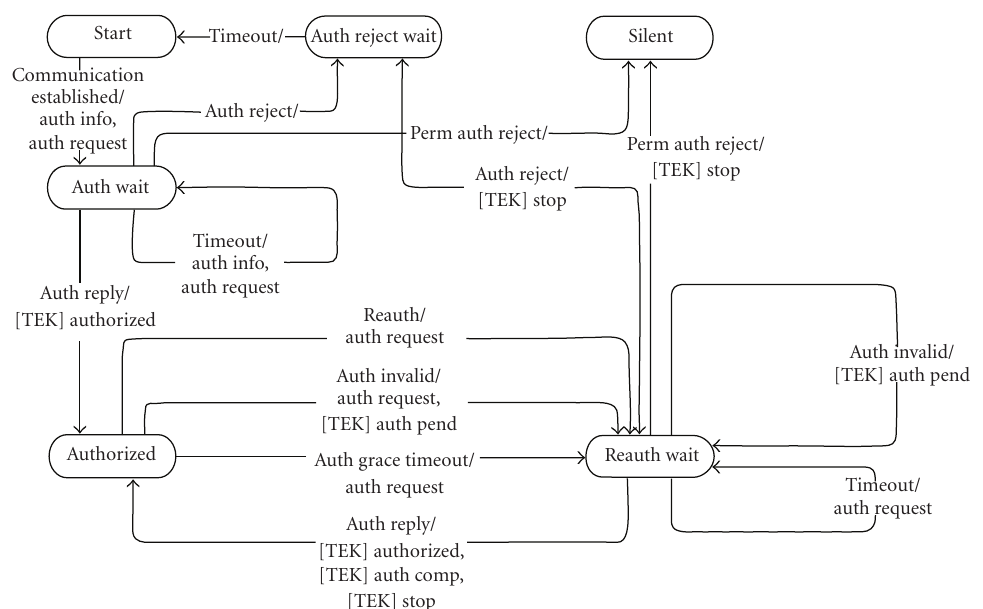
Figure 8: Authorization Finite State Machine Flow